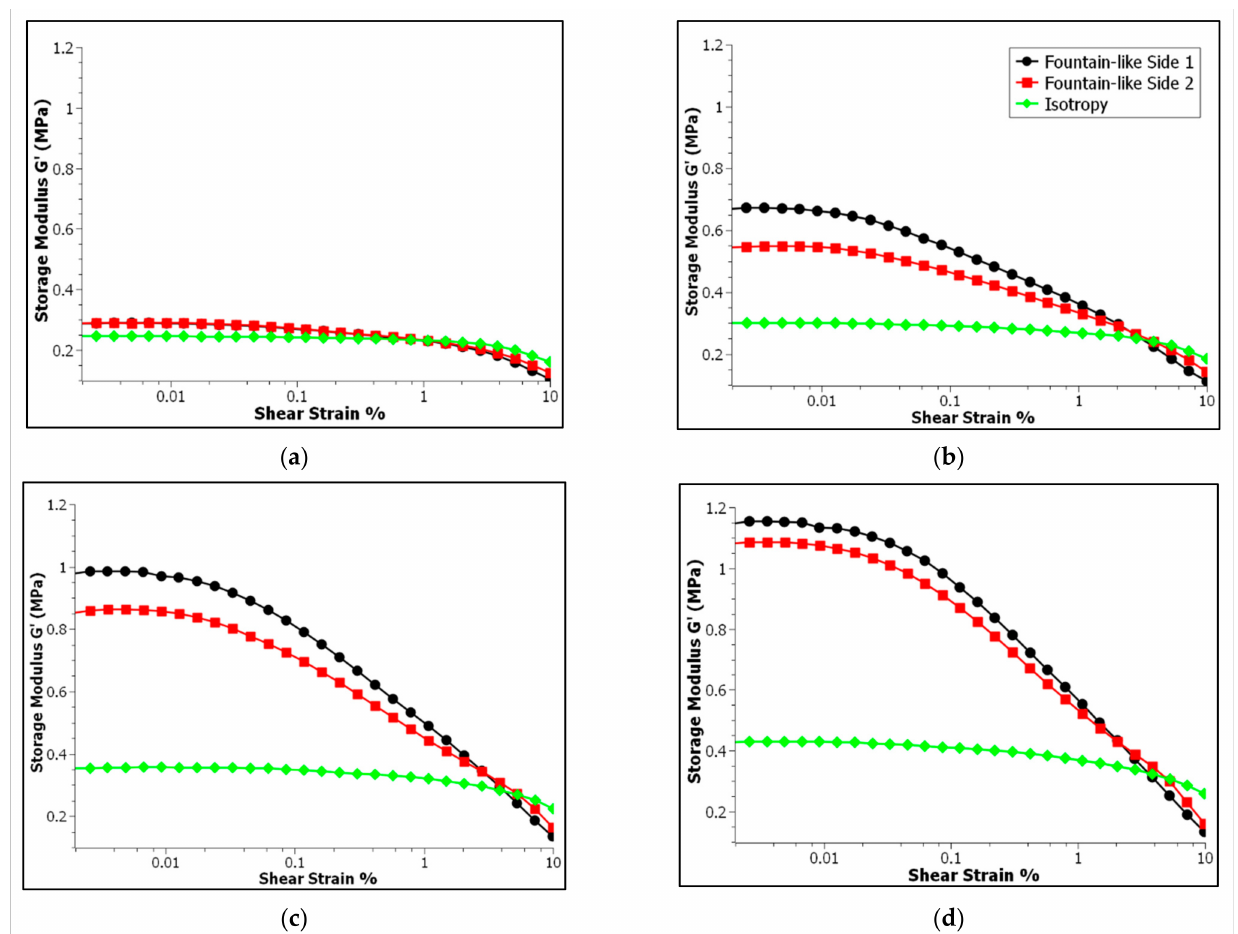
Figure 6. Storage modulus of MRE samples as a function of oscillation shear strains: ( a ) at 0 A, ( b ) at 1A, ( c ) at 2 A and ( d ) at 3 A, which correspond to 0, 0.2, 0.4 and 0.6 T magnetic fields,